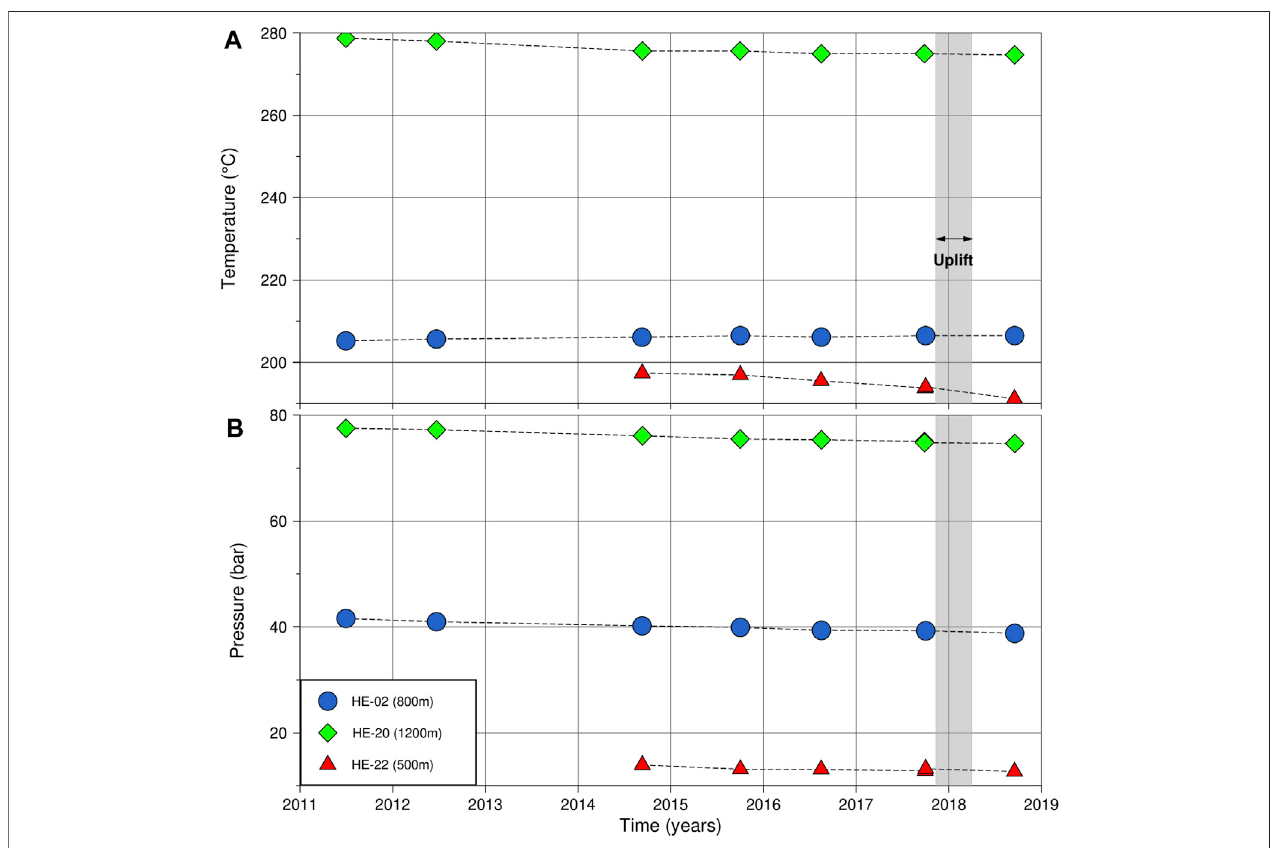
FIGURE8| Temperature (A) andpressure (B) between2011and2018 ata fi xeddepthalongthewellpathsofboreholesHE-02(800 m),HE-20(1,200 m)andHE- 22 (500 m) in the Ölkelduháls region (location in Figure 1 ). The depth are along the wells, HE-02 is a near-vertical borehole, whereas HE-20 and HE-22 are inclined.